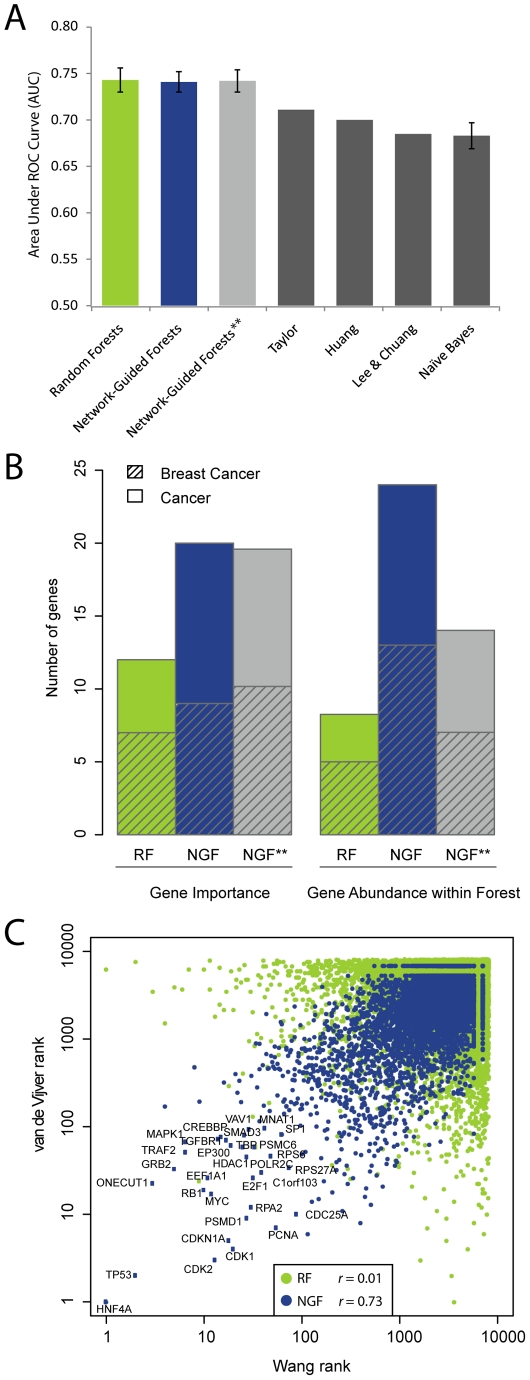
Classification performance and validation of markers of breast cancer metastasis.(A) Average area under the ROC curve for NGF, RF, NGF applied to permuted networks (NGF**), and Naïve Bayes, compared to reported scores for representative previous methods (error bars denote standard deviation estimated over 100 runs). (B) General cancer and breast cancer associated genes identified among the 100 top-scoring genes or 100 most abundant genes in the forest created using RF or NGF. using the real network or networks with permuted edges (average over 100 permutations is shown). (C) Genes ranked by their importance for classification in two independent breast cancer patient cohorts (y vs. x axis). Network-Guided Forest, blue points; regular Random Forest, green points.